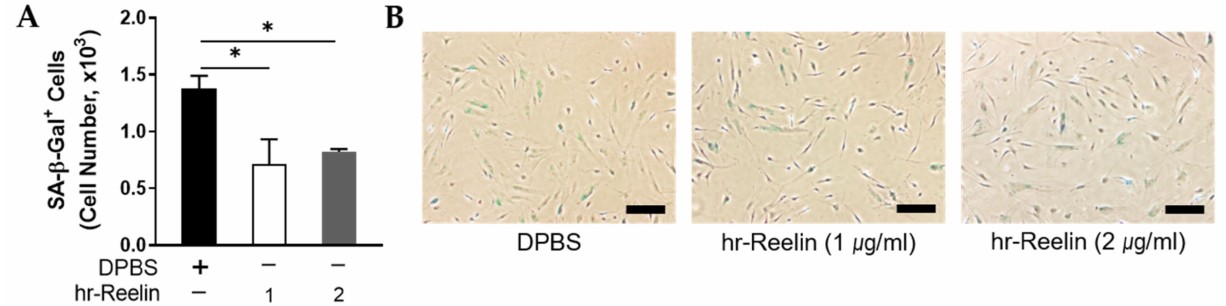
Figure 6. Cell senescence evaluated by β -galactosidase (SA- β -Gal) staining at passage 8 treated with human recombinant Reelin (hr-Reelin) protein in Parkinson’s disease (PD) patient MSCs. ( A ) SA- β -Gal-positive cells were compared between DPBS-treated group and 1 µ g/mL or 2 µ g/mL hr-Reelin-treated group. ( B ) Representative images. Scale bars= 50 µ m. n = 6 for DPBS-treated group, n = 3 for hr-Reelin-treated groups. Mean ± S.E.M. Student’s t -test, * p <